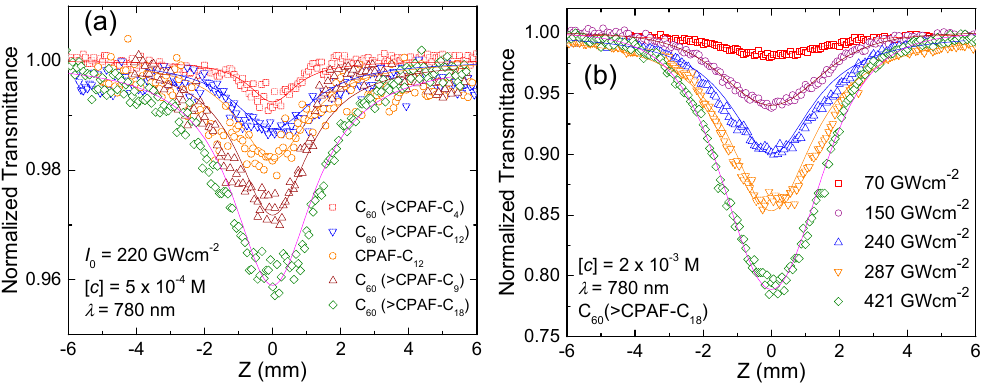
Figure 5. Open-aperture Z -scan curves of ( a ) CPAF-C 12 and four C 60 (>CPAF-C n ) monoadducts taken at 220 GWcm − 2 in THF and ( b ) C 60 (>CPAF-C 18 ) taken at different pulse laser intensities indicated.